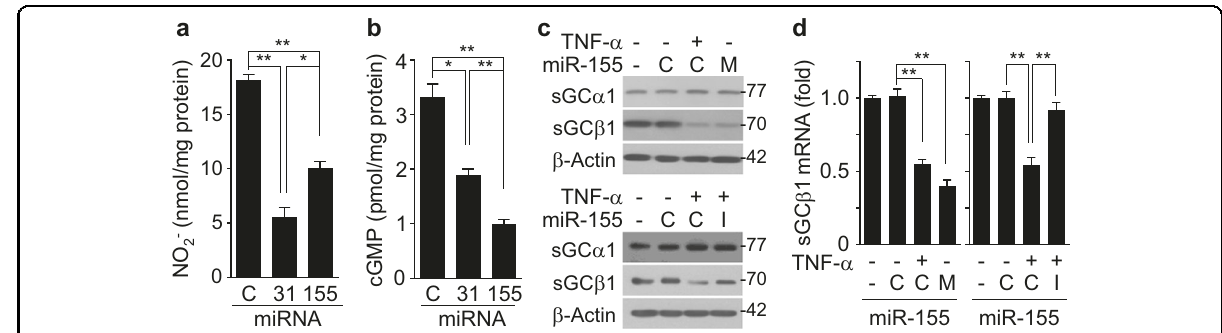
Fig. 1 Different effects of TNF- α -induced miR-31 and miR-155 expression on NO and cGMP production in HUVECs. HUVECs were transfected with 80 nM of control miRNA (C), miR-31 mimic (31), or miR-155 mimic (155) and then stimulated with or without TNF- α (10 ng/mL) for 24 h. a The NO 2- levels were determined in culture supernatants by the Griess reaction ( n = 4). b The cellular cGMP levels were determined using a cGMP assay kit ( n = 4). c , d HUVECs were transfected with 80 nM of a speci fi c control (C) for miR-155 mimic or miR-155 inhibitor, miR-155 mimic (M), or miR-155 inhibitor (I) and stimulated with or without TNF- α (10 ng/mL) for 24 h. The protein and mRNA levels of sGC α 1 and sGC β 1 were measured by Western blotting and qRT-PCR ( n = 4). * P < 0.05 and ** P <